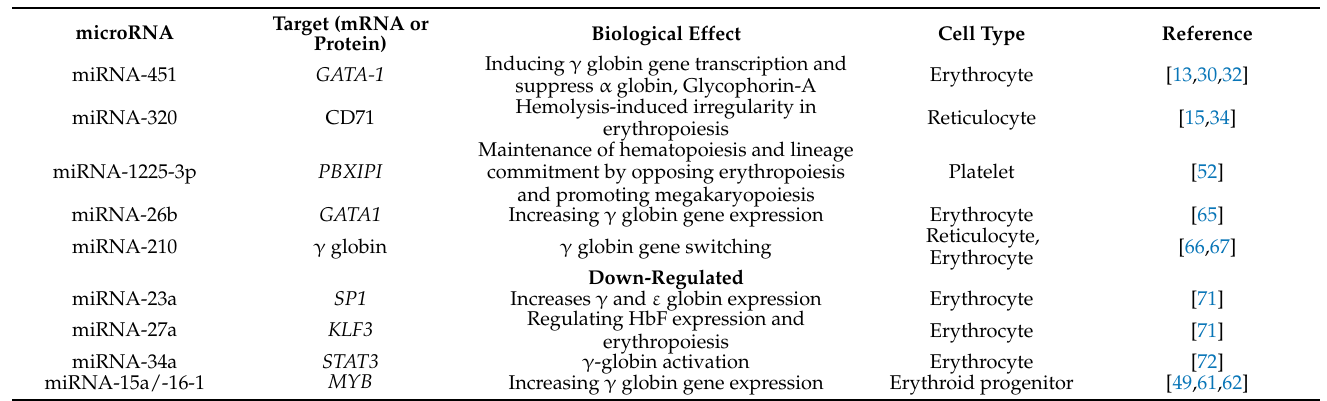
BCL11A: B-cell lymphoma/leukemia 11A protein, CD71: Transferrin receptor, CDS region; Coding DNA Sequence region mRNA, DNMT: DNA methyltransferase 1, GATA1: GATA-binding factor 1 mRNA, HbF: Fetal hemoglobin, KLF3: Krüppel-like factor 3 mRNA, KLFD: Krüppel-like factor d mRNA, MYB: Proto-oncogene mRNA, NRF2; Nuclear factor (erythroid-derived 2)-like 2 mRNA, PBXIPI: PBX homeobox interacting protein 1, SP1; Specificity protein 1 mRNA, and STAT3: Signal transducer and activator of transcription